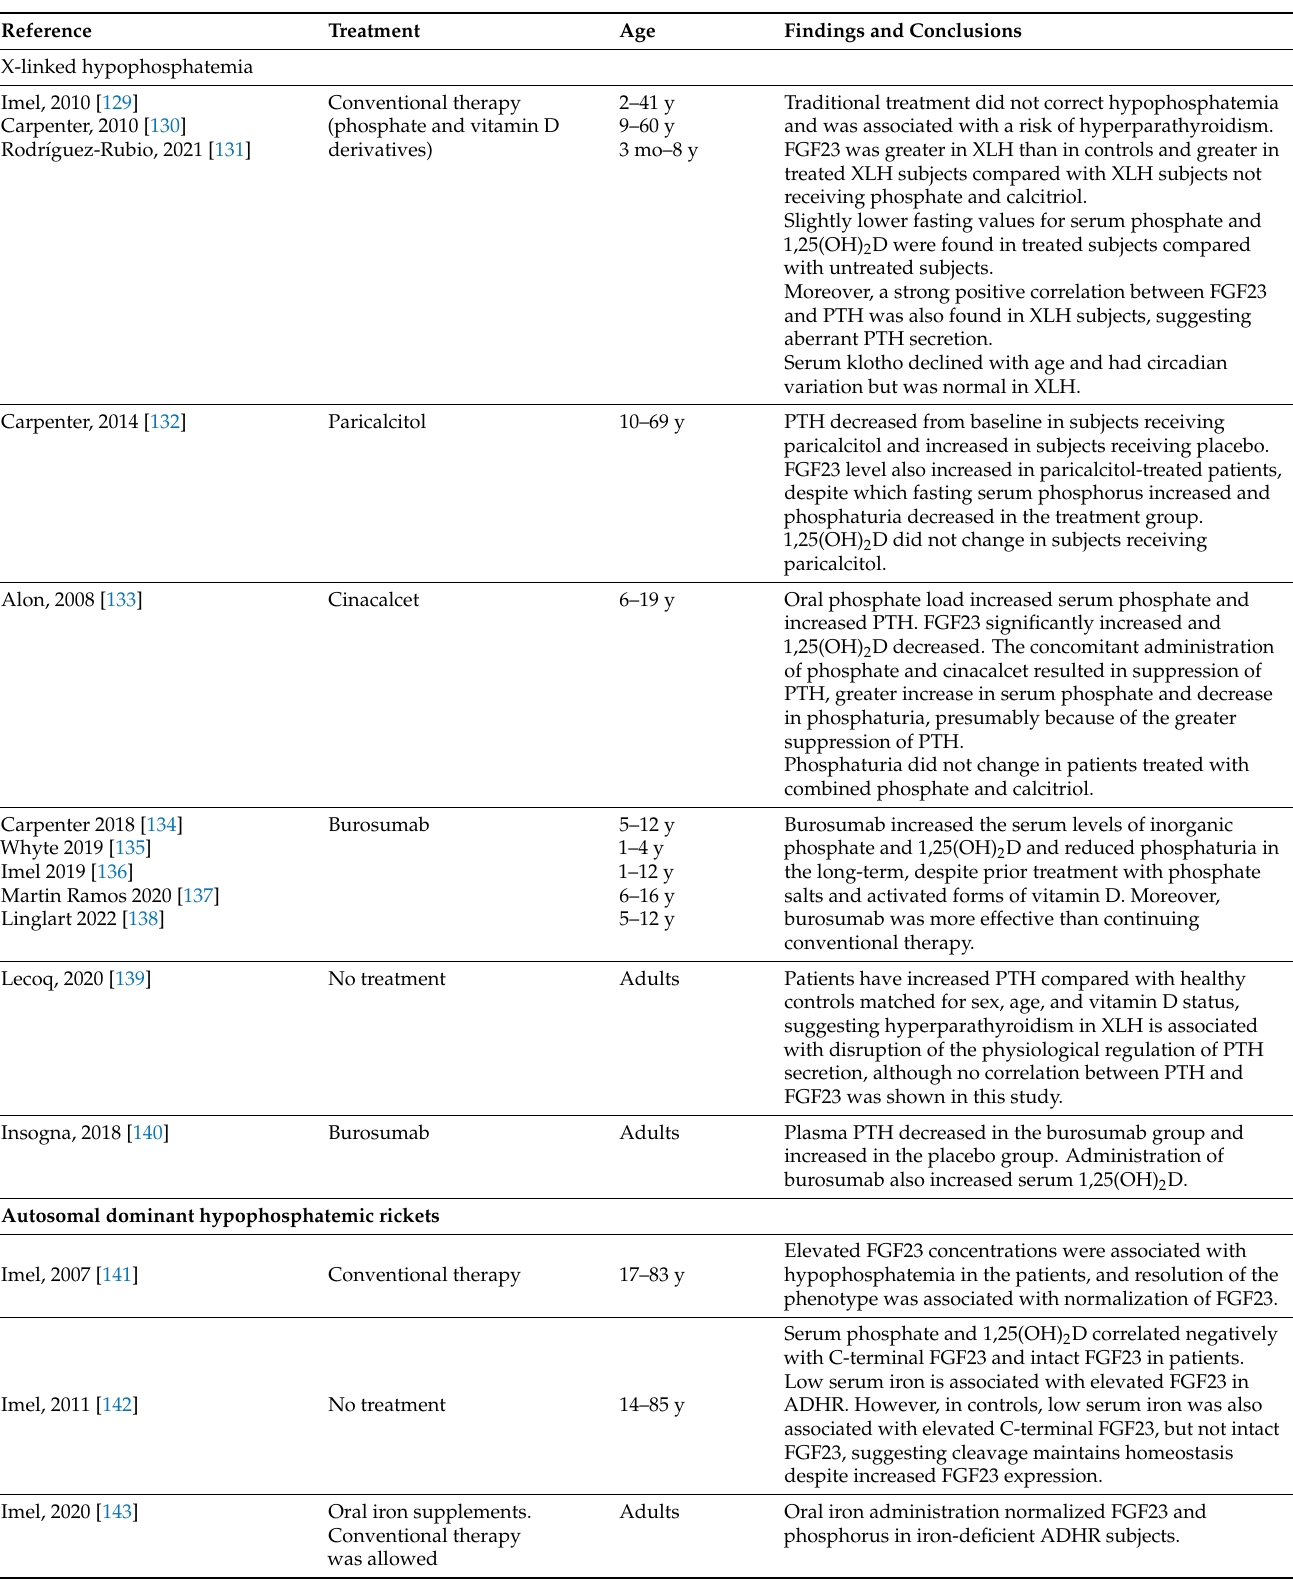
Table 8. Most significant studies that analyze the effects of treatment and the interaction between fibroblast growth factor 23 (FGF23), klotho and vitamin D in patients with phosphate disorders